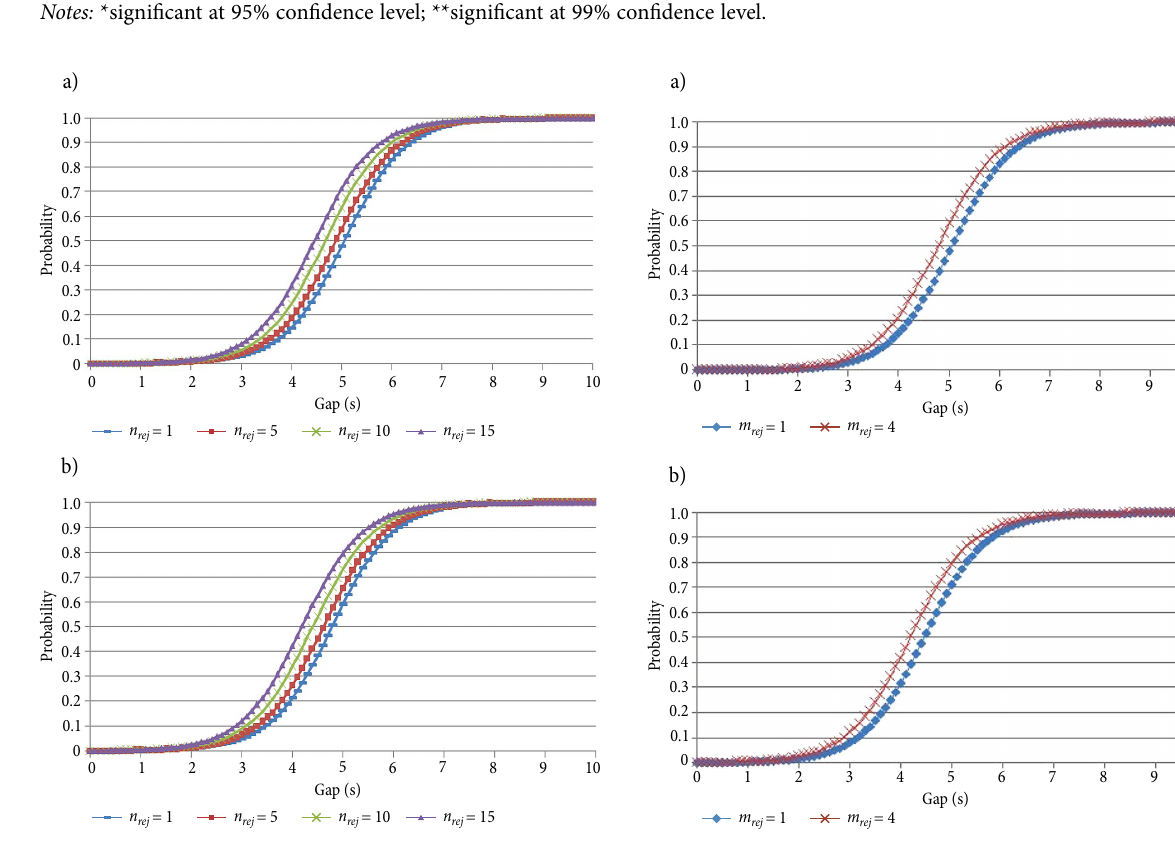
Fig. 2. Gap acceptance probability functions by the mean time interval of rejected gaps: a – n rej = 1; b – n rej = 15